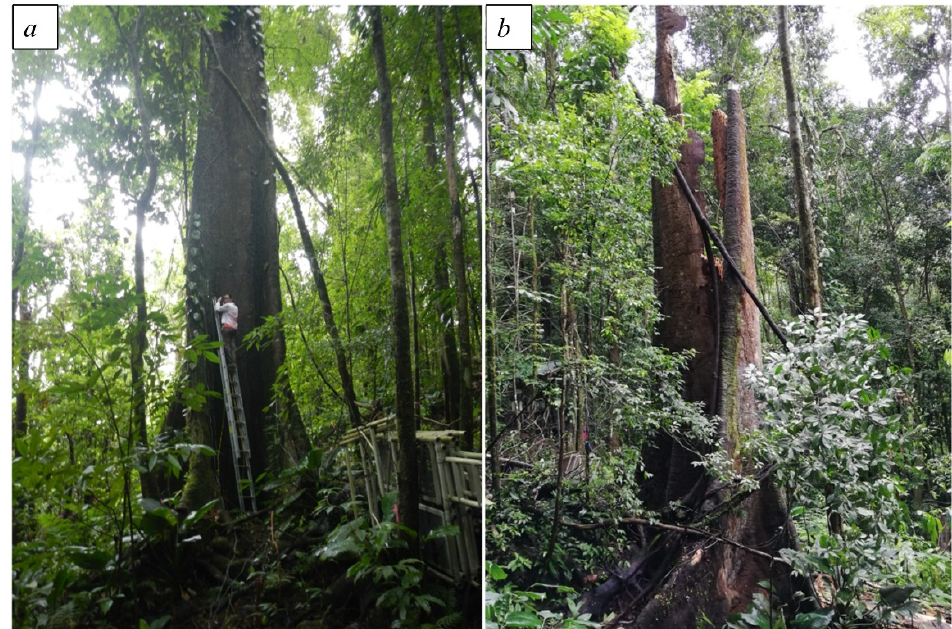
Figure 1. Image of the emergent M. anisophyllum species pre-death ( a ) and post-death ( b ). Photo credits: Luiza Aparecido ( a ); Eugenio Gonzalez ( b ).